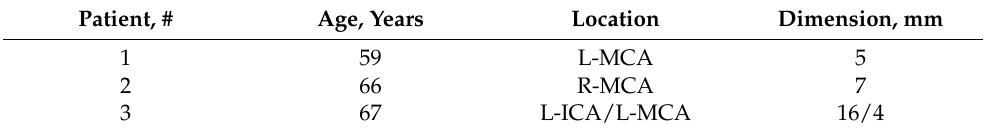
Table 1. Main information and characteristics of the patients and their cerebral aneurysms. L-MCA: left middle cerebral artery; R-MCA: right middle cerebral artery; L-ICA: left internal carotid artery. Patient, # Age, Years Location Dimension, mm 1 59 L-MCA 5 2 66 R-MCA 7 3 67 L-ICA/L-MCA